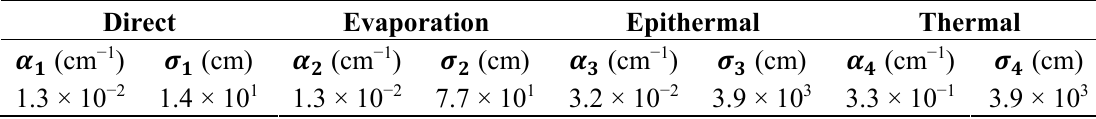
Table 3. Neutron attenuation parameters and Gaussian width parameters for the four neutron